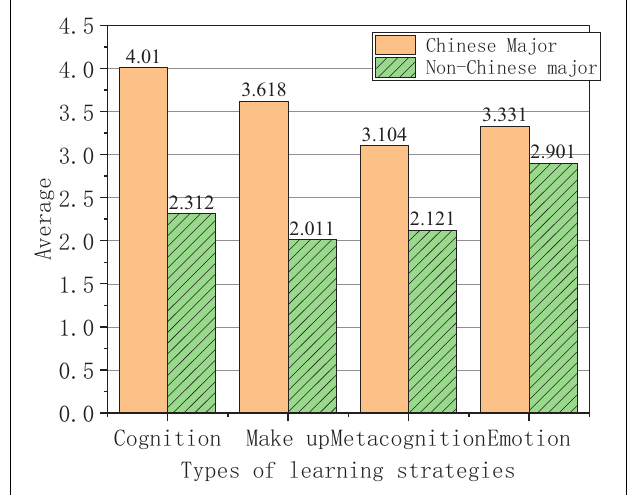
FIGURE 8 | Use of specific learning strategies for different